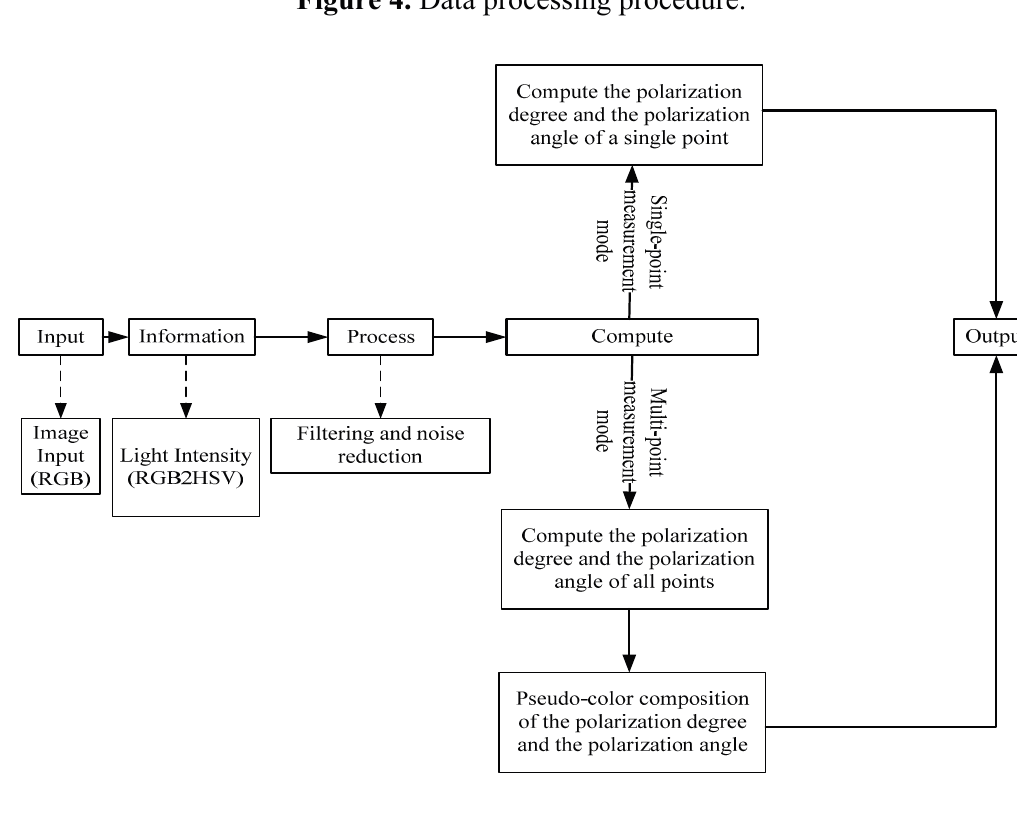
Figure 4. Data processing